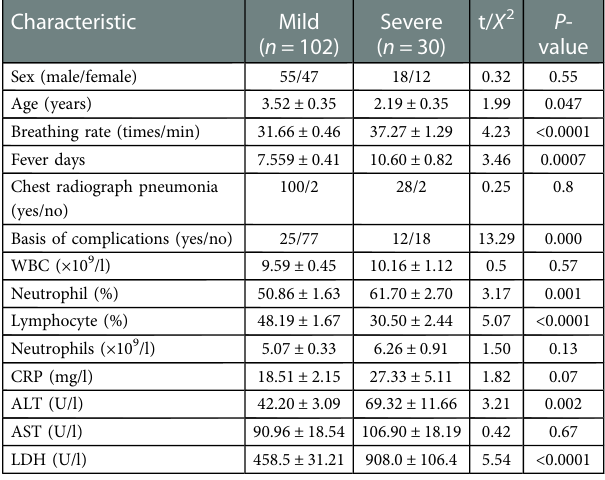
TABLE 3 Predictive results of the early recognition scale for critically ill children with adenovirus pneumonia in a historical cohort. Sensitivity and speci fi city were 93.3% and 92.1%, and the diagnostic consistency was